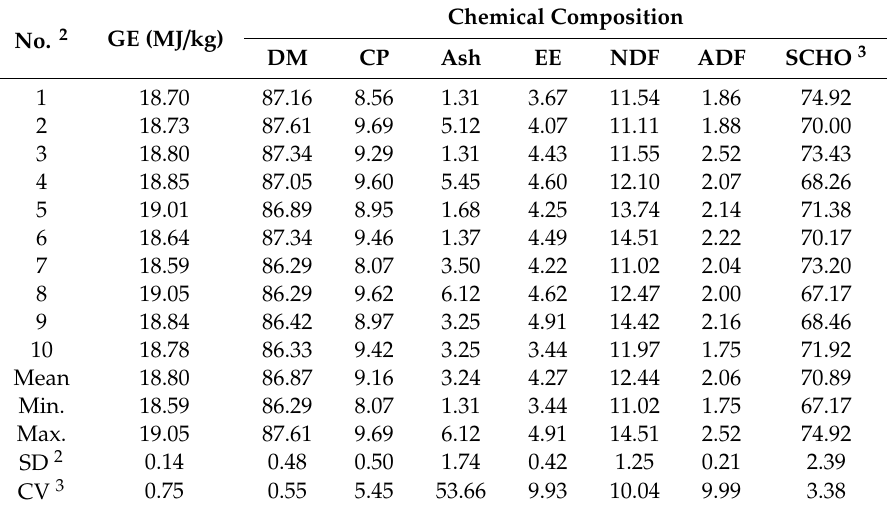
Table 3. Analyzed chemical composition of corn (%, DM basis) 1 .